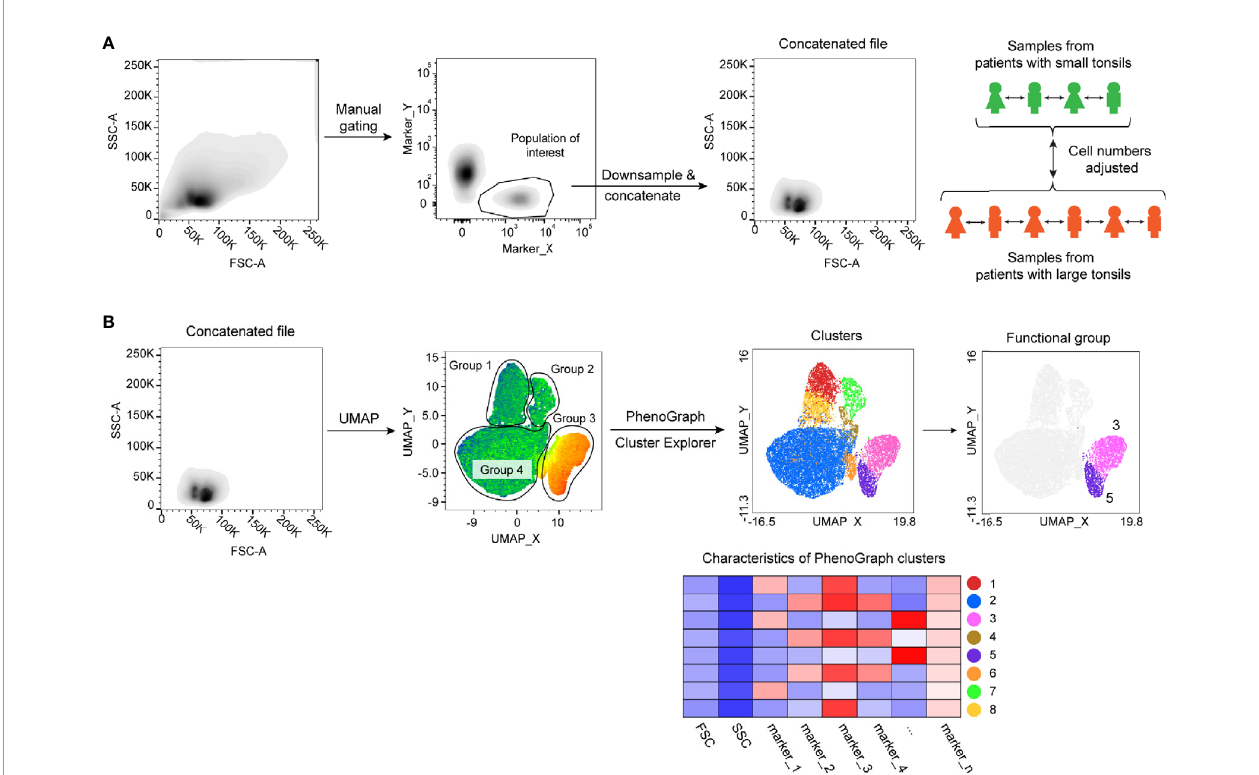
FIGURE 1 | Flow cytometric data analysis work fl ow. (A) Schematics showing sample concatenation of cell populations derived from the same patient group. (B) UMAP and PhenoGraph analysis work fl ow of concatenated